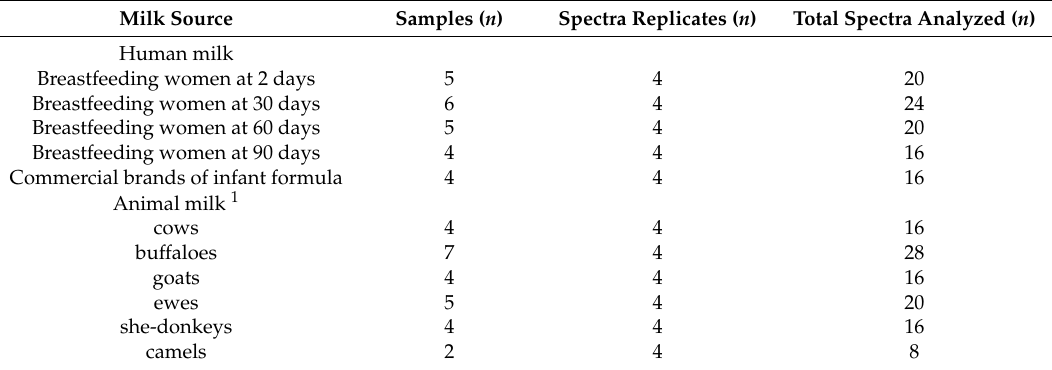
Table 1. Milk samples analyzed and relative mass spectra